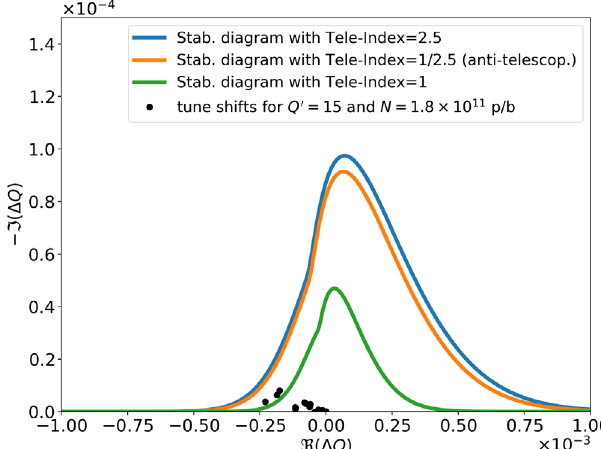
FIG. 3. Typical improvement of the beam stability diagram (SD) thanks to (anti-)telescopic optics at constant MO current (350 A with positive polarity), assuming a linear chromaticity of Q 0 ¼ 15 units (as in Run 2). The coherent modes are super- imposed, assuming a bunch population of 1 . 8 × 10 11 p = b within a normalized emittance of γϵ ¼ 1 . 8 μ m, as calculated from the strict LHC Run 3 impedance model and multiplying the resulting coherent tune shifts by an extra empirical factor of 2 (as observed in Run 2 [10]). Courtesy of